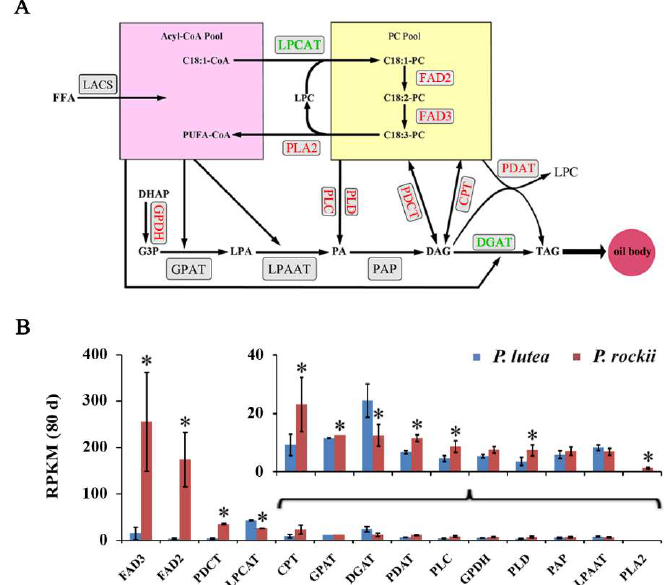
Figure 4. Differential lipid gene expression in endoplasmic reticulum (ER) between the two species. ( A ) Schematic outline of genes encoding for triacylglycerol assembly in ER and their ( B ) transcript levels in matured seeds (80 days). For gene abbreviations see Table S4. Genes represented in red letters indicate significant difference in their expression levels between the two species, with a ratio of P. rockii to P. lutea ≥ 1.5; and genes represented in green letters indicate the P. rockii is significantly lower than P. lutea in their expression levels. RPKM: reads per kilobase per million. The asterisks indicate significant differences (* p < 0.05, Student’s t